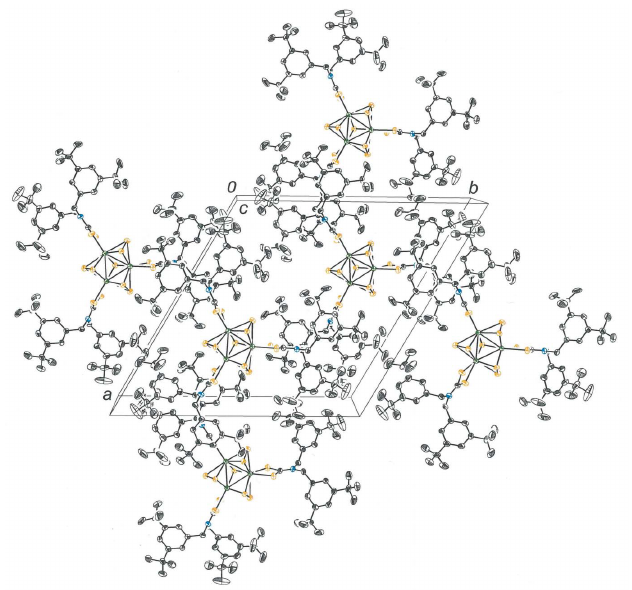
Figure 2 Cell packing diagram for the [Mo 3 S 7 (S 2 CN(CH 2 C 6 H 3 -3,5- t Bu 2 ) 2 ) 3 ] + cations showing the numerous interligand hydrophobic interactions. The view is down the c axis. All hydrogen atoms are omitted for clarity.